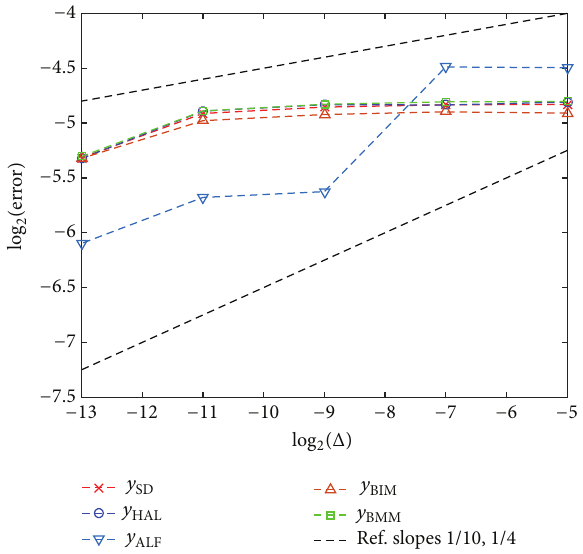
Figure 1: Convergence of fully implicit SD, HAL, ALF, BIM, and BMM schemes applied to SDE (2) with parameters ,𝑘 , 𝑘 ,𝑘 , 𝑞,𝑇) = (1/16, 1/16, 1, 0.4, 3/4, 1). (𝑥 0 1 2 3